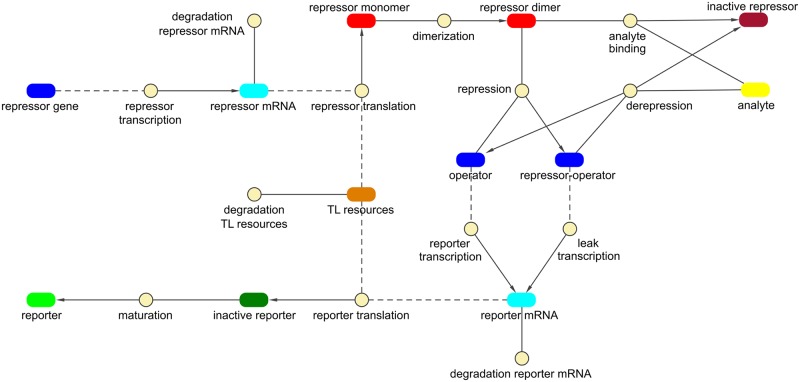
Illustration of the biosensor model.A model of the expression of a repressor-controlled reporter protein by CFPS was established. The rounded rectangles represent species such as DNA and proteins and the circles represent reactions. Lines indicate that a species is an educt in a reaction, arrows show that a species is the product of a reaction. Dashed lines mean that the species takes part in a reaction but is not consumed by it.